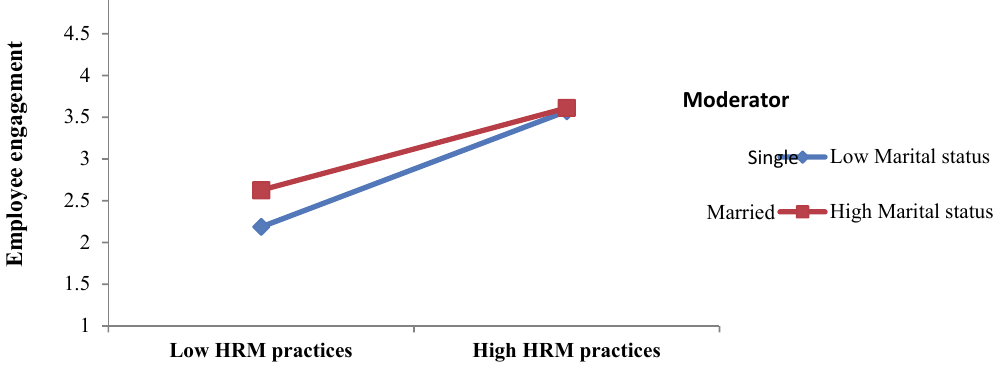
Fig. 5. The effect of HRM practices on employee engagement is weaker with married